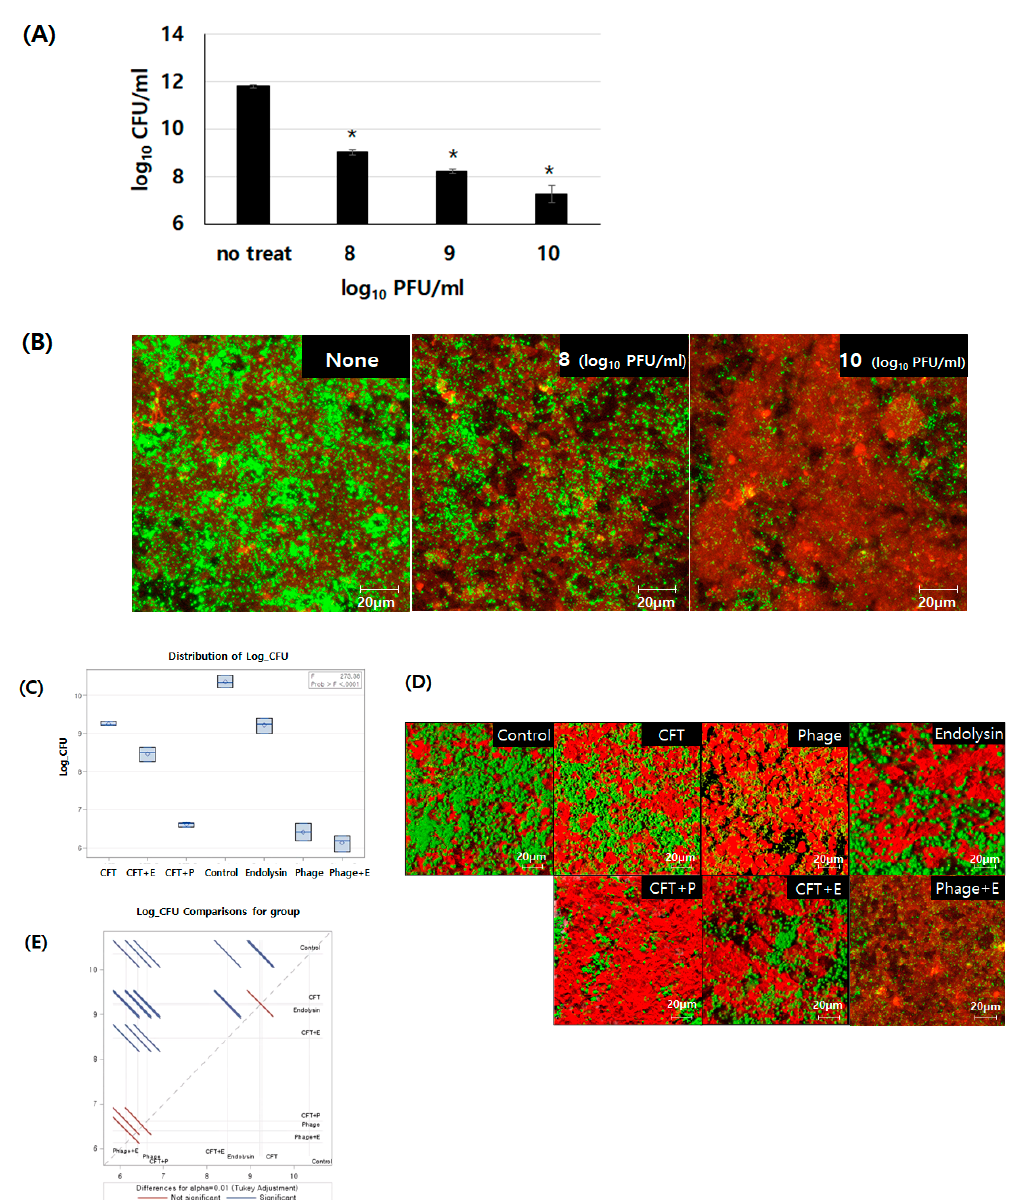
Figure 4. Biofilm removal efficacy of each antibacterial agent on in vitro cultured human intestinal cells. ( A ) After treatment with various concentrations of phages, the remaining bacterial load was recovered and counted as colony-forming units (CFUs). * p < 0.05. ( B ) Observation of remaining bacterial load after phage treatment on biofilm formed on top of in vitro cultured human intestinal cells. E. faecalis expressing green fluorescent protein (GFP) is shown in green, while human intestinal cells immunostained with anti-F actin antibody are shown in red. ( C ) After treatment with each agent, the remaining bacterial load was recovered and counted as colony-forming units (CFUs). CFT, cefotaxime; E, endolysin; P, phage PBEF129. Control is where the biofilm was treated with no agent. The experiment was performed in triplicate. ( D ) Observation of remaining bacterial load after each treatment on biofilm formed on top of in vitro cultured human intestinal cells. E. faecalis expressing green fluorescent protein (GFP) is shown as green, while human intestinal cells immunostained with anti-F actin antibody are shown as red. ( E ) Analysis of statistical significance among each treatment. The diffogram shows the result of Tukey’s test. Blue lines mean p <